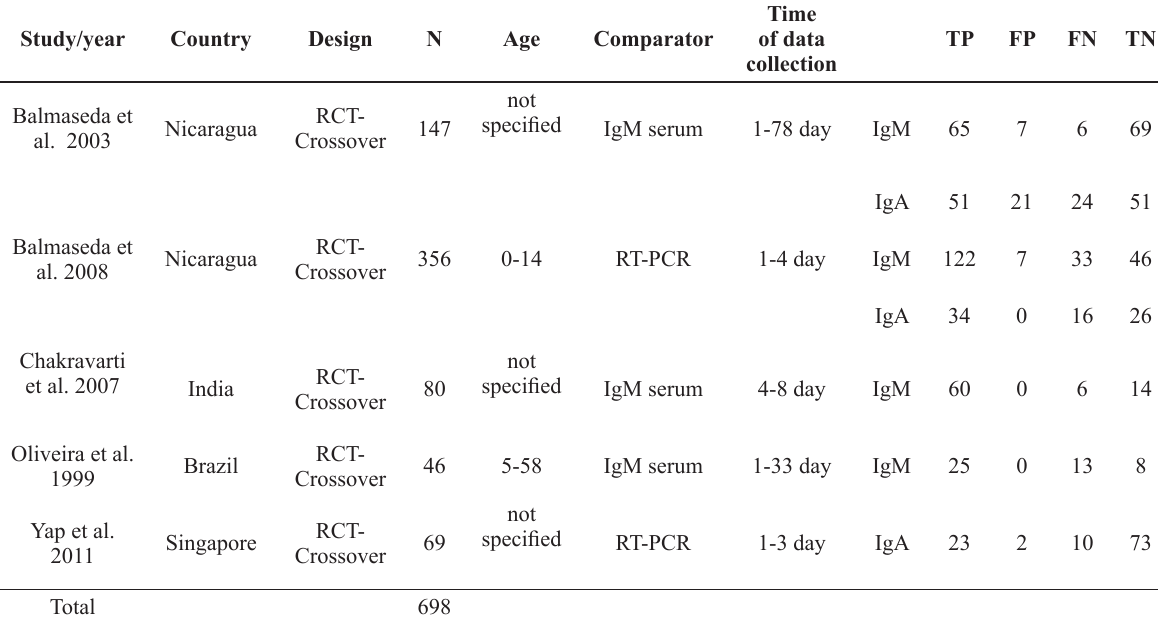
Characteristics of included studies.